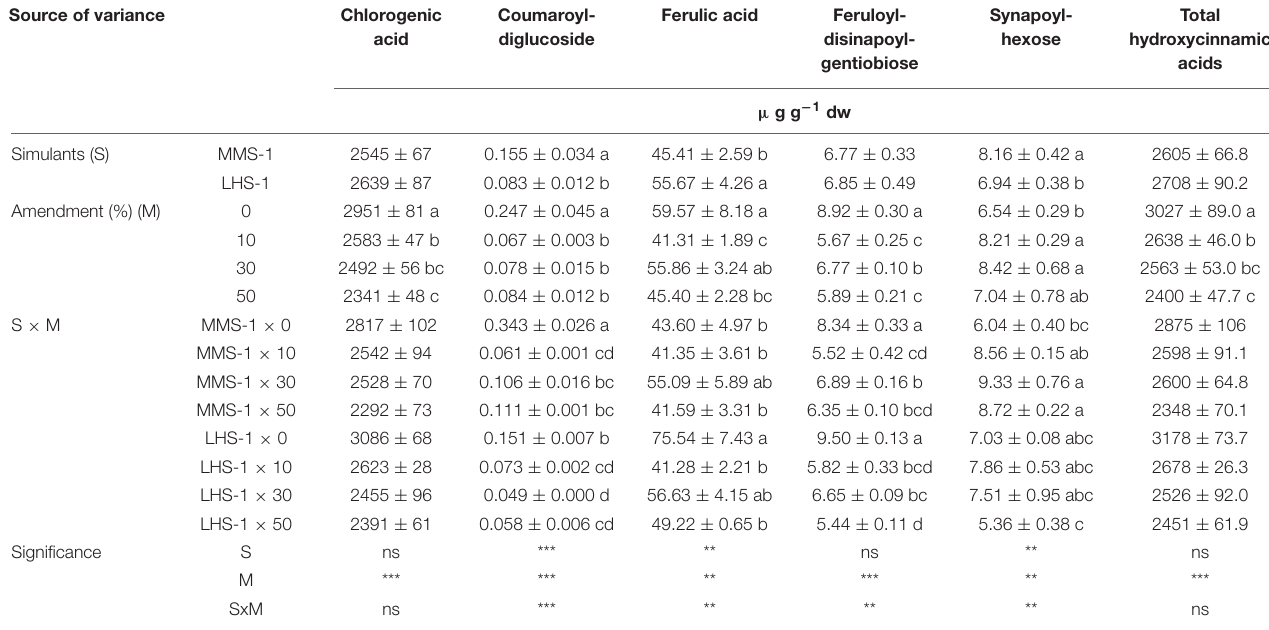
TABLE 3A | Phenolic profiles and total phenolic composition of lettuce grown in different mixtures of MMS-1 or LHS-1 simulants and manure (simulant/manure rates: 100:0, 90:10, 70:30, 50:50; w/w). Source of